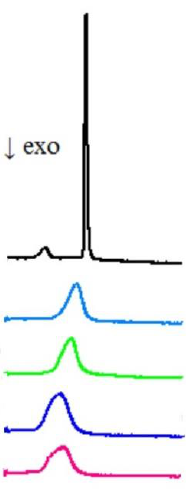
Figure 3. Thermograms (heat versus temperature) obtained for 1,2-dipalmitoyl-s n -glycero-3-phosphatidylcholine (DPPC) mixed with compound 7c as well as for pure lipid (the first curve from the top—black). Curves in the figure represent the thermograms obtained for different molar ratios (studied compound DPPC—from the bottom: 0.12, 0.10, 0.08, 0.06, pure lipid). The exothermic direction in this graph is downward.